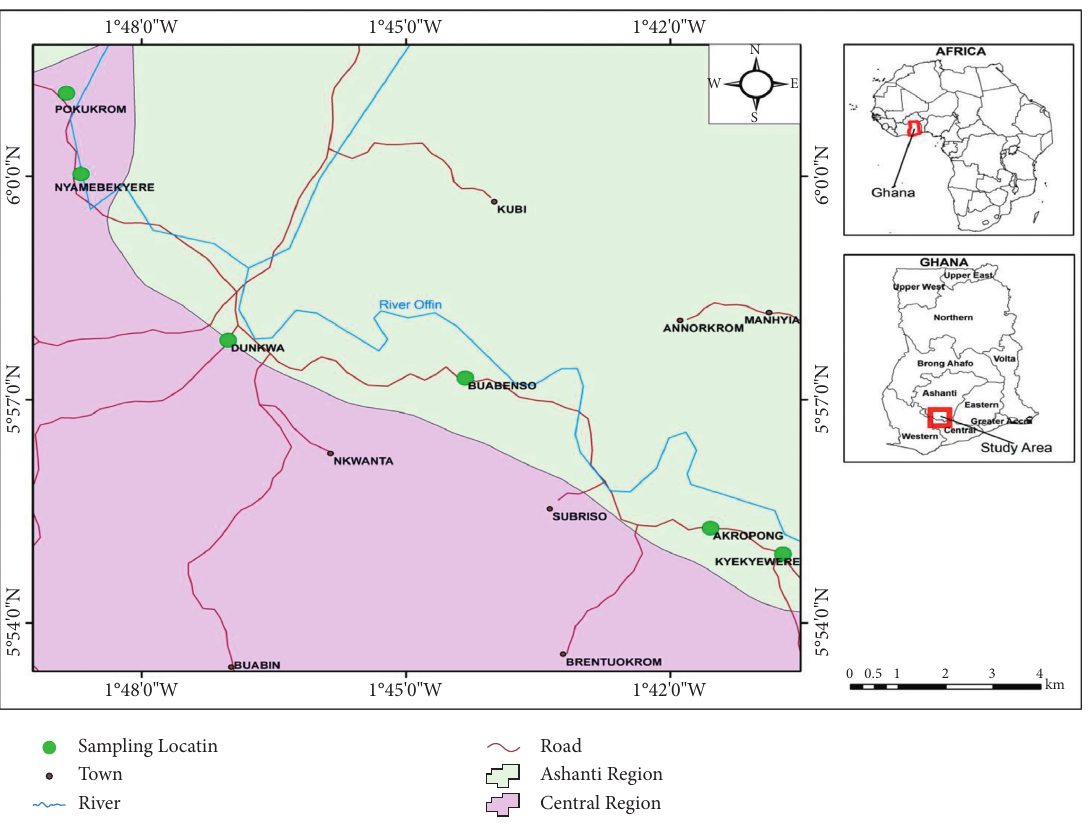
Figure 1: Map of study area showing the sampling Table 1: Sampling location, pit status of sampling site, and years of fallow of the mined area. Sample location